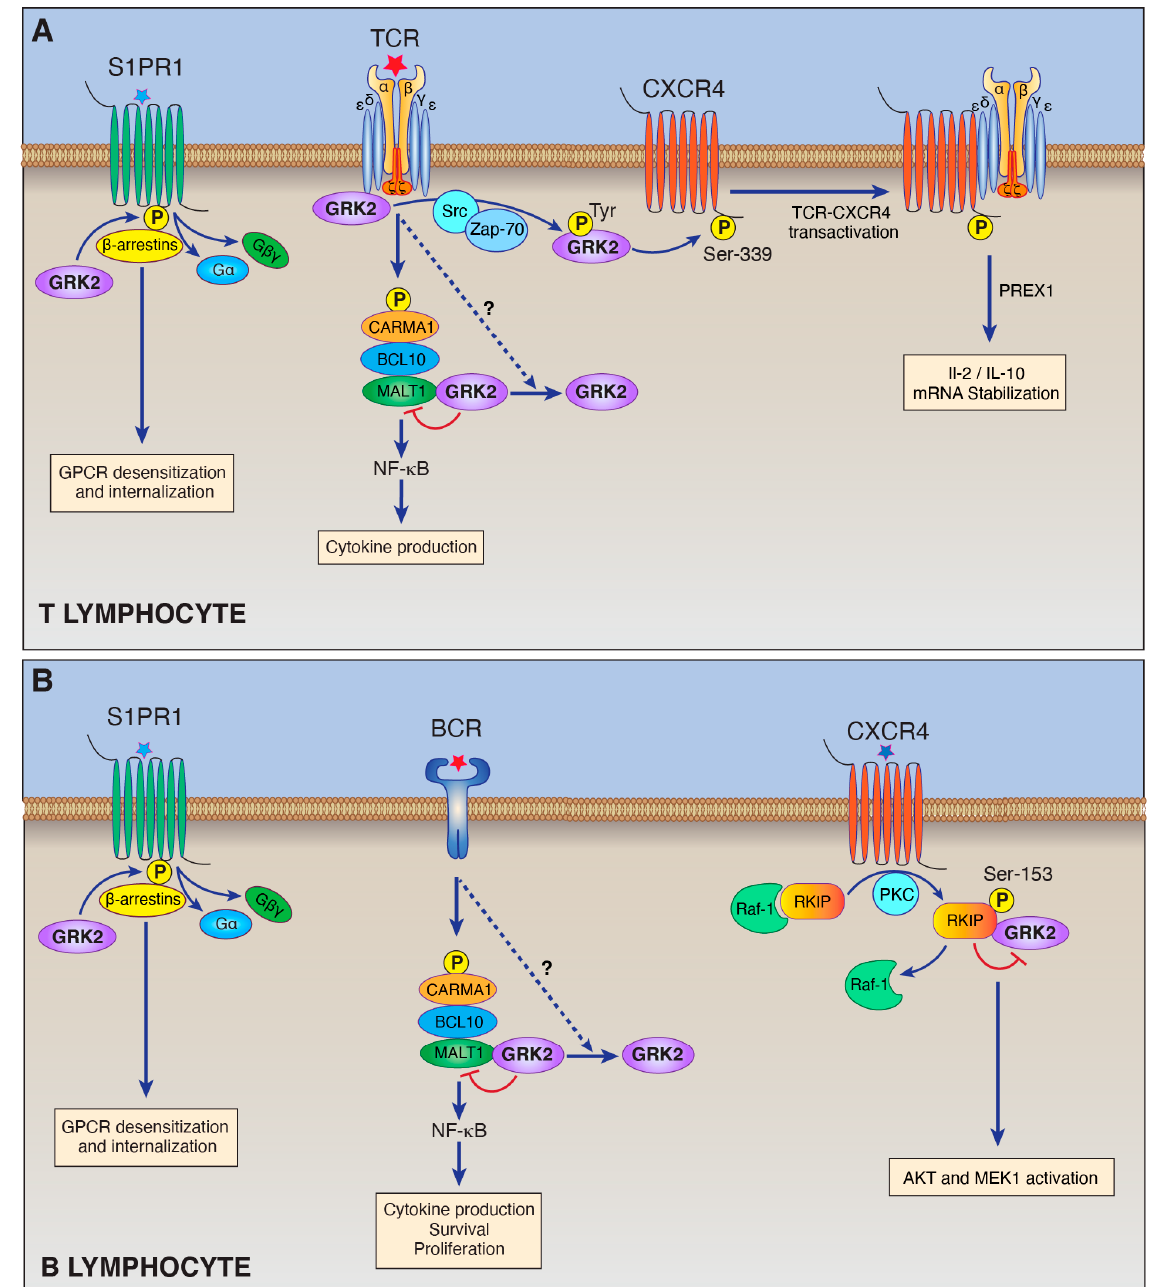
Figure 1. Schematic illustration of the roles of GRK2 in lymphocytes (see text for explanation of abbreviations). ( A ) GRK2 performs multiple functions in T lymphocytes. GRK2 carries out its canonical function of phosphorylating specific GPCRs including S1PR1. In this way, GRK2 works together with arrestins to trigger GPCR desensitization. GRK2 also has several non-canonical functions in T cells. GRK2 can directly associate with the TCR-CD ε subunit. GRK2 also undergoes tyrosine phosphorylation in response to TCR stimulation, and phosphorylated GRK2 then phosphorylates and transactivates CXCR4, which drives TCR-CXCR4 complex formation and consequent downstream signaling. In addition, our laboratory recently demonstrated that GRK2 binds to MALT1, the effector molecule of the CARMA1-BCL1-MALT1 complex, and inhibits its activity. ( B ) GRK2 performs multiple functions in B lymphocytes. GRK2 phosphorylates specific GPCRs including S1PR1 to mediate GPCR desensitization. One of GRK2 ′ s non-canonical roles in B-cells is its interaction with RKIP. PKC-dependent phosphorylation of RKIP results in RKIP dissociation from Raf-1 and association with GRK2. GRK2 binding to RKIP is thought to prevent GRK2 ′ s binding and inhibition of MEK1 and AKT. In the B-cell malignancy, ABC-DLBCL, GRK2 may serve as a tumor suppressor by binding and inhibiting the MALT1 proto-oncoprotein.